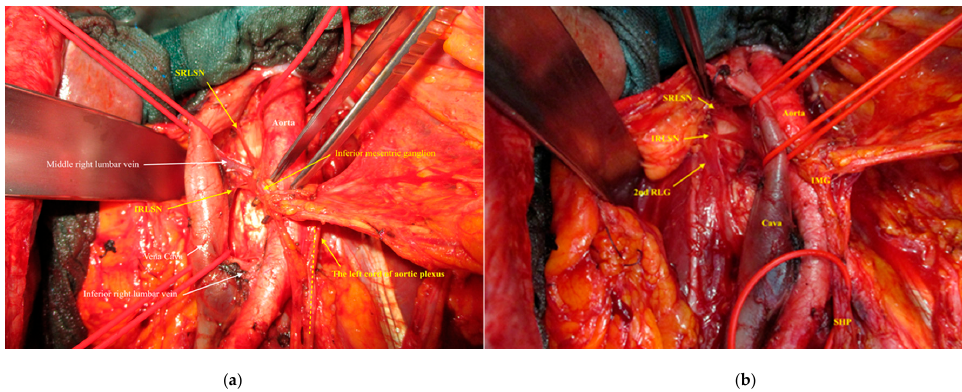
Figure 3. Medial and lateral views of the dissected right cord of the aortic plexus in a patient during the primary cytoreductive surgery for ovarian cancer. ( a ) Medial view (interaortocaval space): SRLSN, superior right lumbar splanchnic nerve; IRLSN, inferior right lumbar splanchnic nerve. ( b ) Lateral view (para- and retrocaval space): SRLSN, superior right lumbar splanchnic nerve; IRLSN, inferior right lumbar splanchnic nerve; 2nd RLG, second right lumbar ganglion of sympathetic trunk; IMG, inferior mesenteric ganglion; SHP, superior hypogastric plexus.